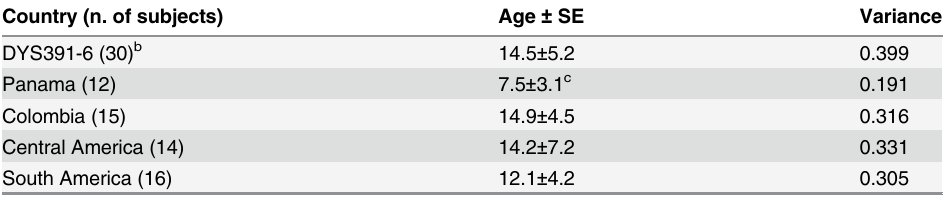
a Only the six Y-STR loci in common with comparison population samples from literature are considered (S6 Table). b Samples from Battaglia et al. [43]; Nú ñ ez et al. [24]; Julieta Ávila et al. [52]; Ascunce et al. [41];